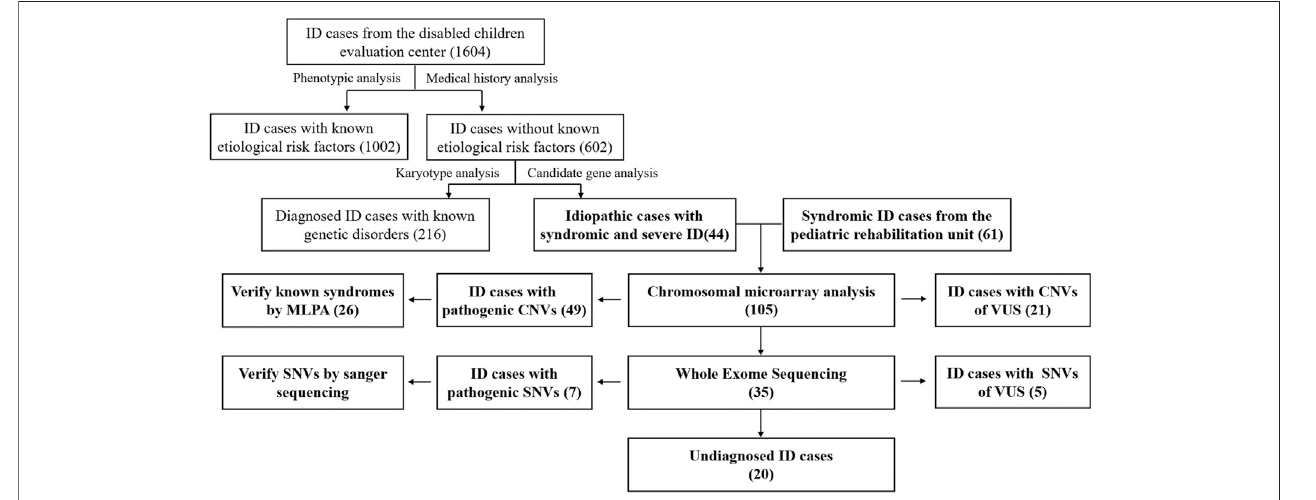
FIGURE 1 | Algorithmic approach for patients with intellectual disability